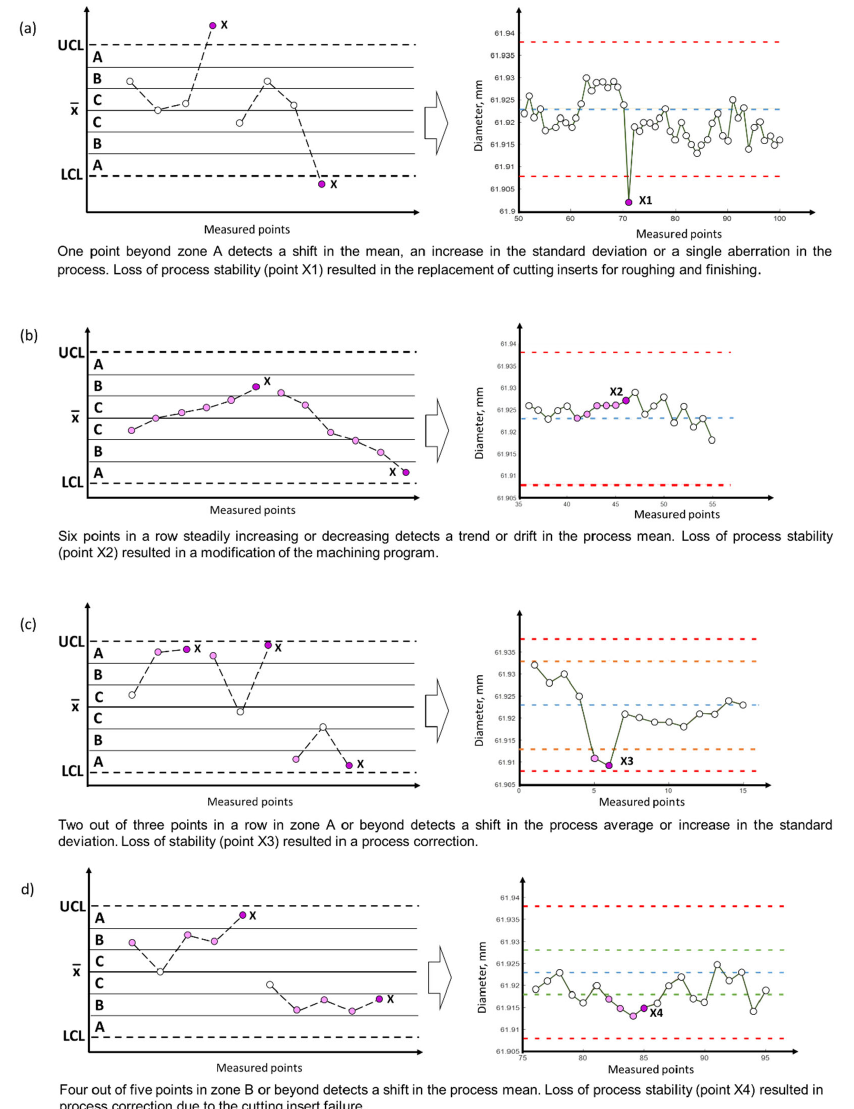
Figure 3. Examples of control chart test for special case variation applied to diameter measurement data at point A on the workpiece: UCL—upper control limit, 𝑥̅ —center line , LCL—lower control limit. A—zone between lines calculated at 2 σ and 3 σ above the center line, B—zone between lines calculated at σ and 2 σ above the center line, C—zone between the center line and the line calculated at σ above the center line.